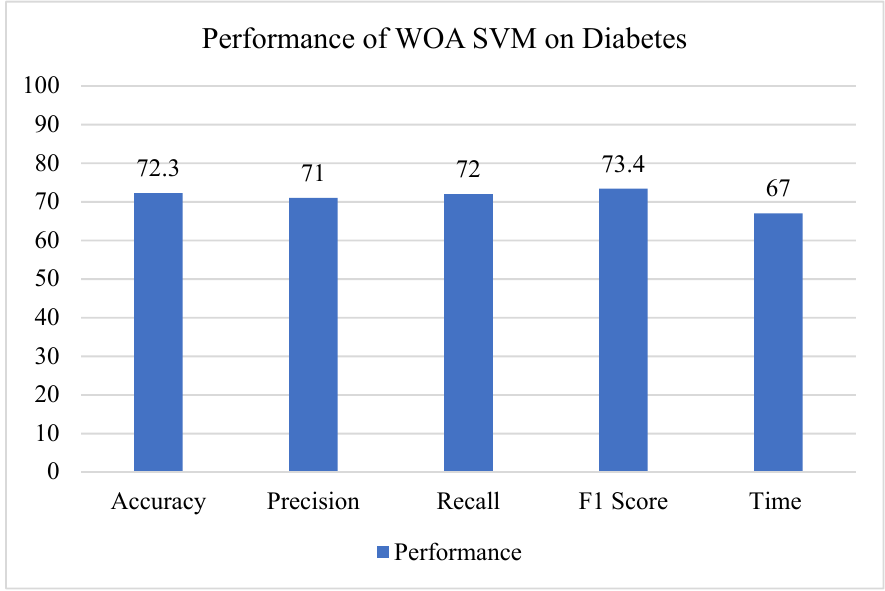
Figure 15. Performance of WOA ‐ SVM in Diabetes.